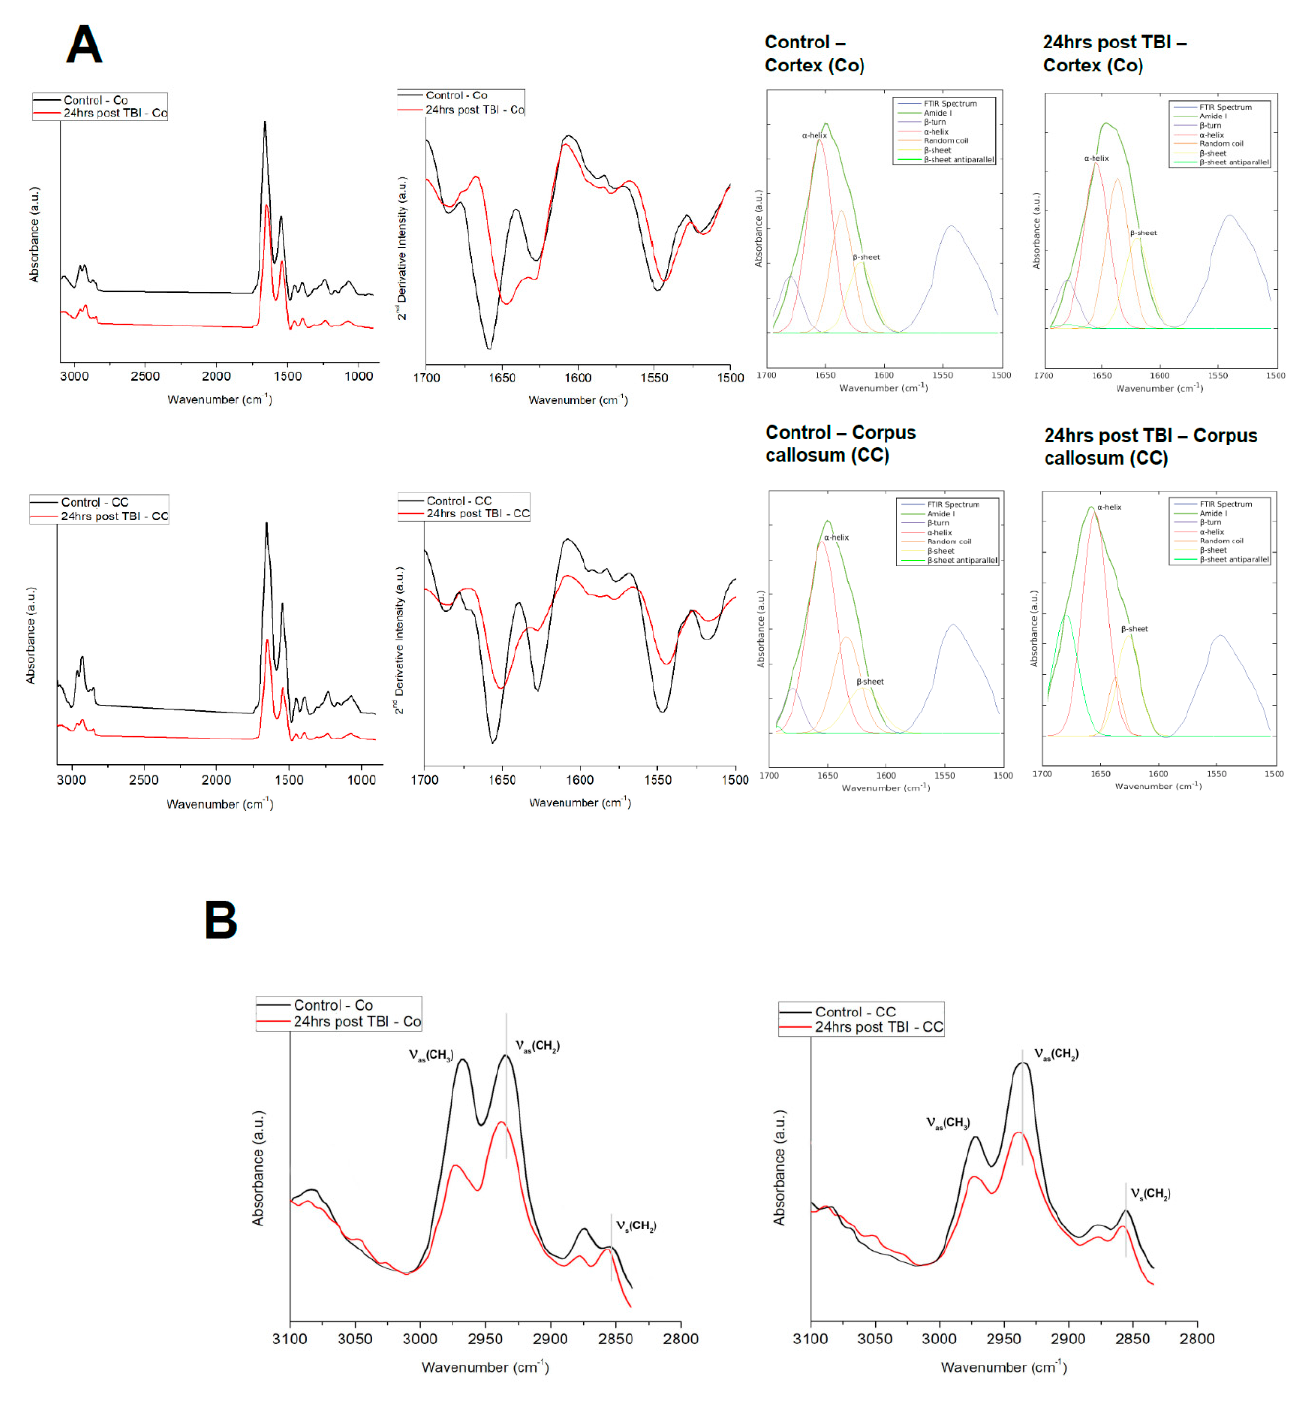
Figure 4. Representative FTIR averaged spectra. ( A ) FTIR averaged spectra in the range of 3100–700 cm − 1 acquired from Co and CC region of control gray matter and white matter. Average second-derivative spectra of the amide I band (spectral range of 1700–1600 cm − 1 ). The spectra show α -helical (secondary protein) structure at 1655 cm − 1 and β -sheets protein conformation at 1630 cm − 1 . Representative curve fitting of the amide I band in the spectral range of 1700–1600 cm − 1 comparing the control and 24 h post-injured Co and CC. ( B ) Representative FTIR spectra averaged from control (black) and mTBI (red) for lipid region in Co and CC.